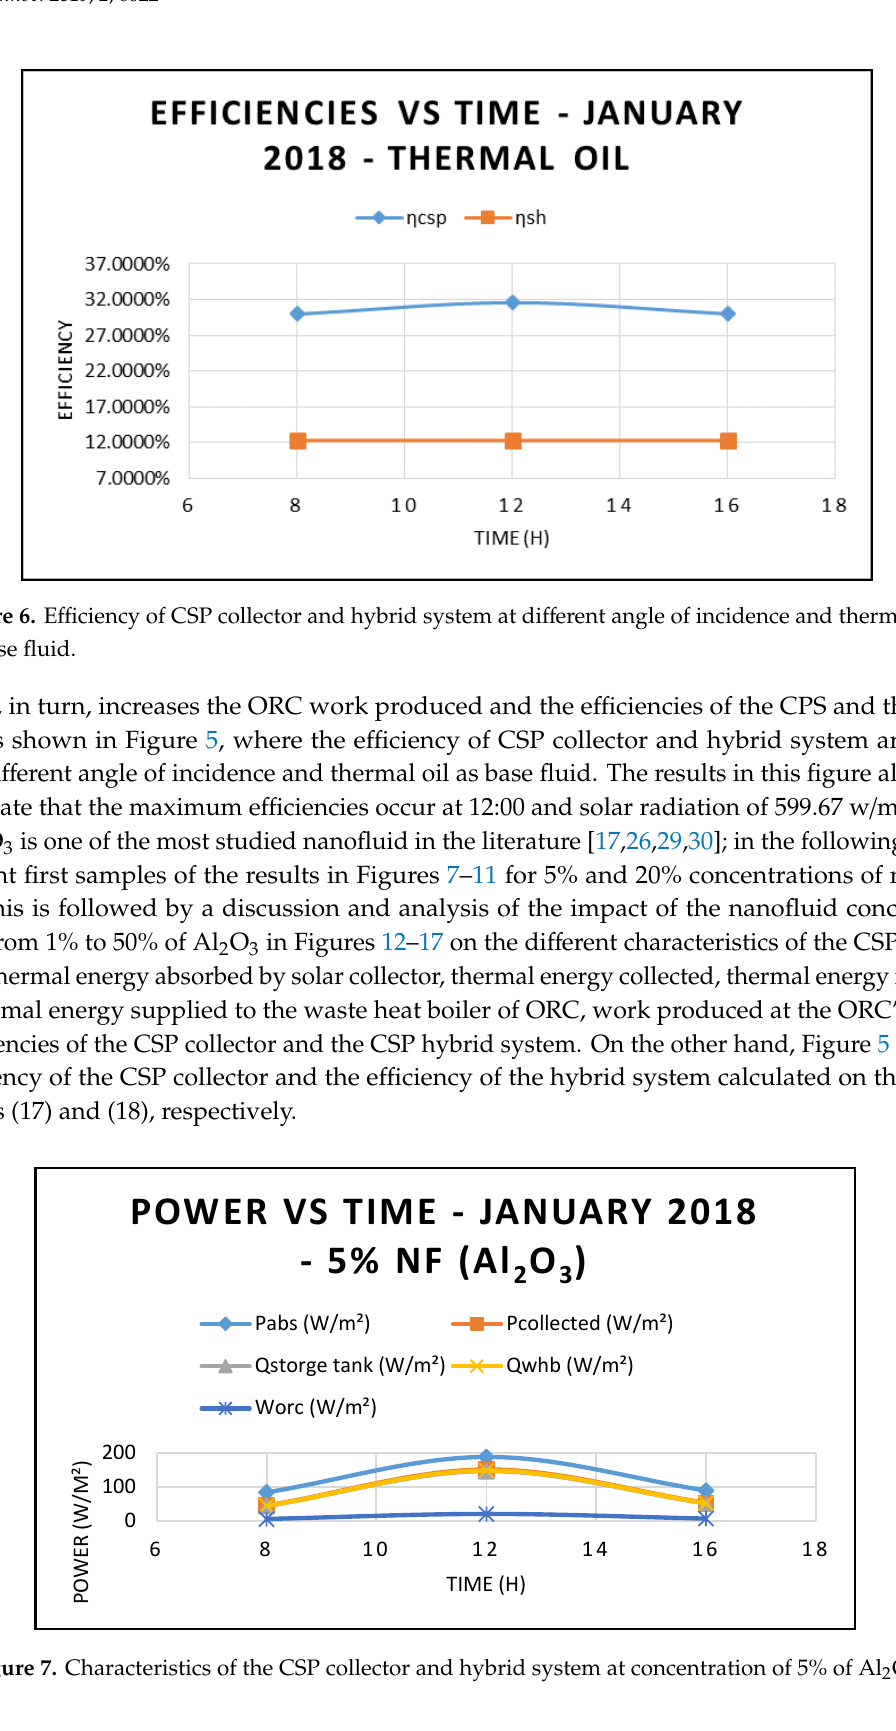
Figure 5. CSP hybrid system results with thermal oil as base fluid.